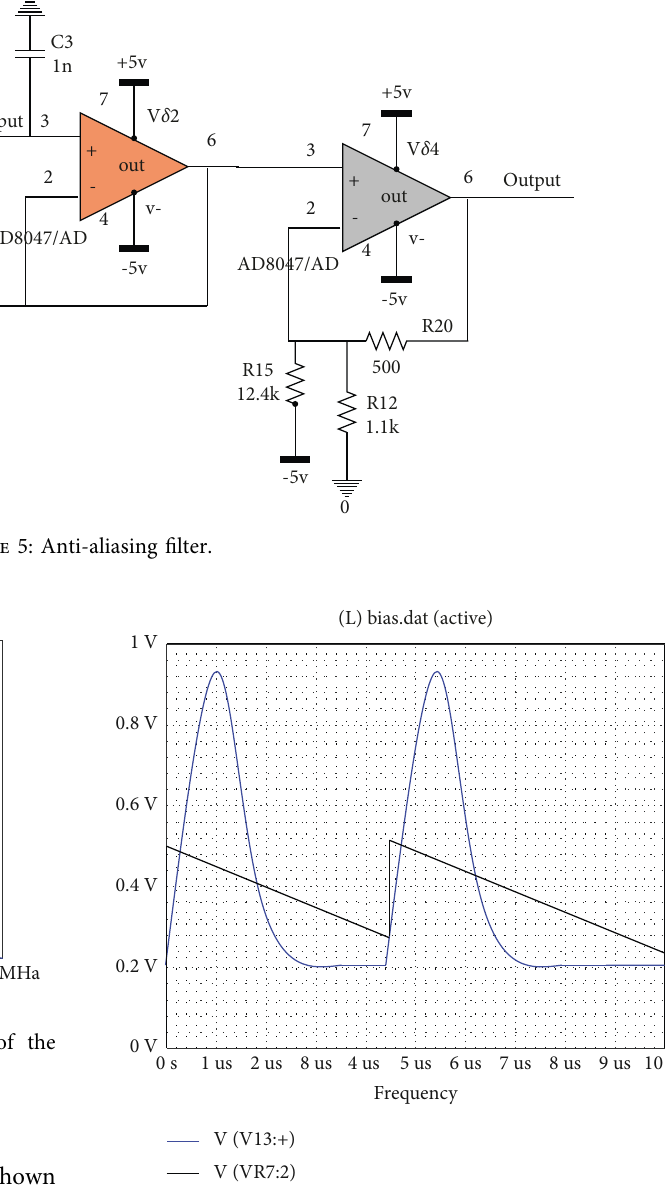
Figure 7: Time domain simulation of analog